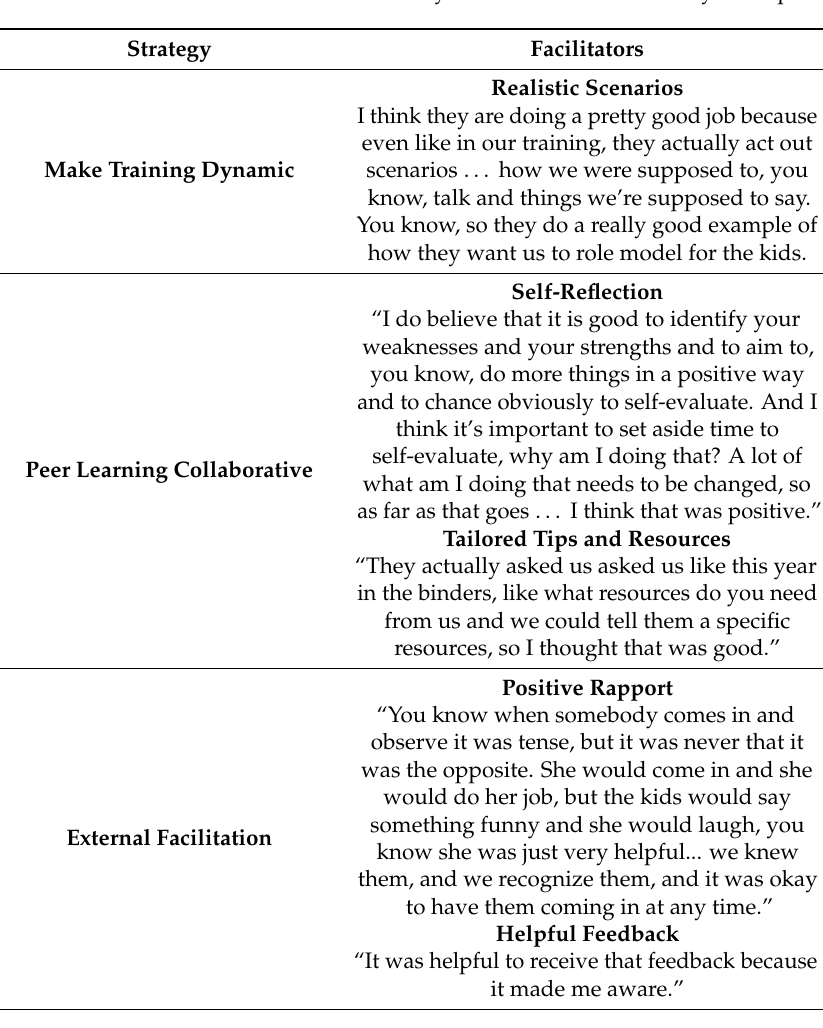
Table 5. Key facilitators and barriers by de-implementation